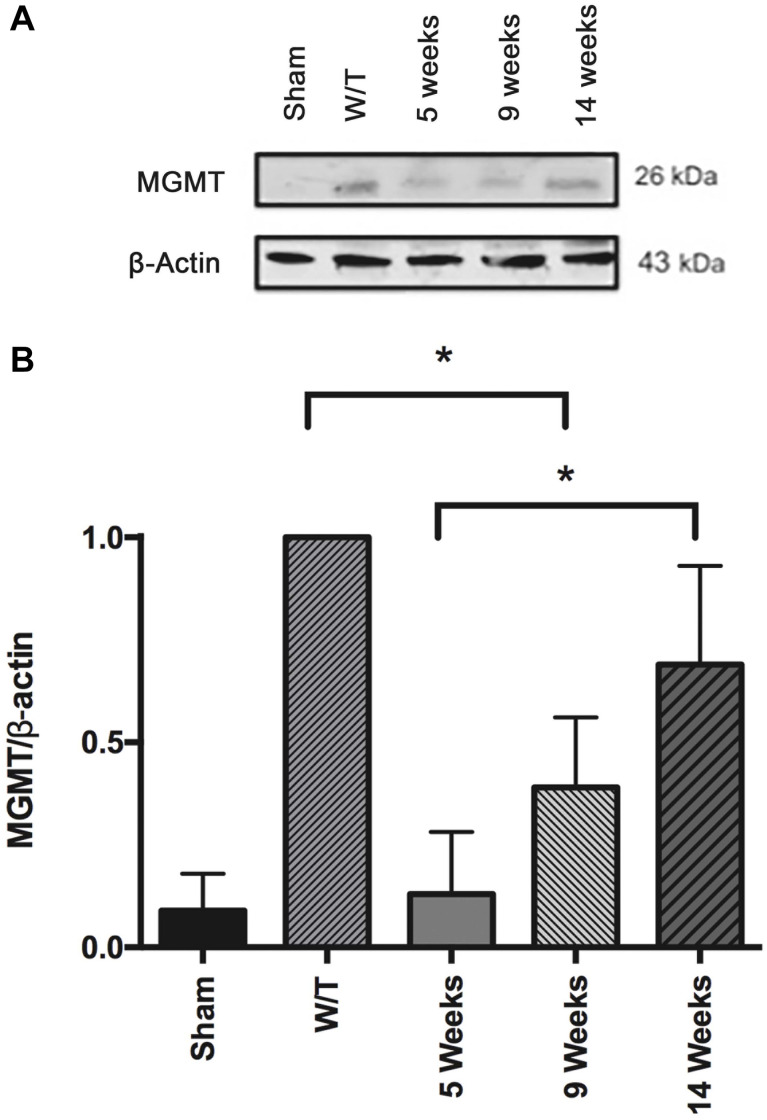
(A) Comparison of the level of the DNA repair enzyme, MGMT, determined by Western blot in the sham-operated rats and two groups of implant-operated animals: one with no drug treatment (W/T) and the other given mifepristone/temozolomide (Mif/Tz) at 5 weeks post-surgery (corresponding to the end of the 3-week drug treatment) and 9 and 14 weeks after surgery. A lower level of MGMT was found in the Mif/Tz versus W/T group at 5 weeks post-surgery, an effect that was gradually reversed. (B) Densitometer analysis (n = 3). Data is expressed as the mean ± SD of three independent experiment. * Significant difference (p < 0.05).